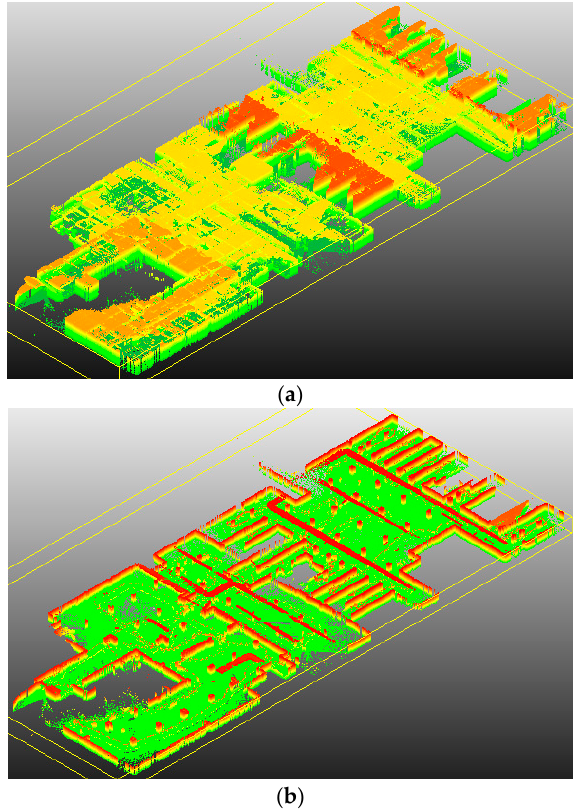
Figure 15. The 3D point clouds of dataset 1. ( a ) 3D point clouds; ( b ) Point clouds after cutting off the roof.